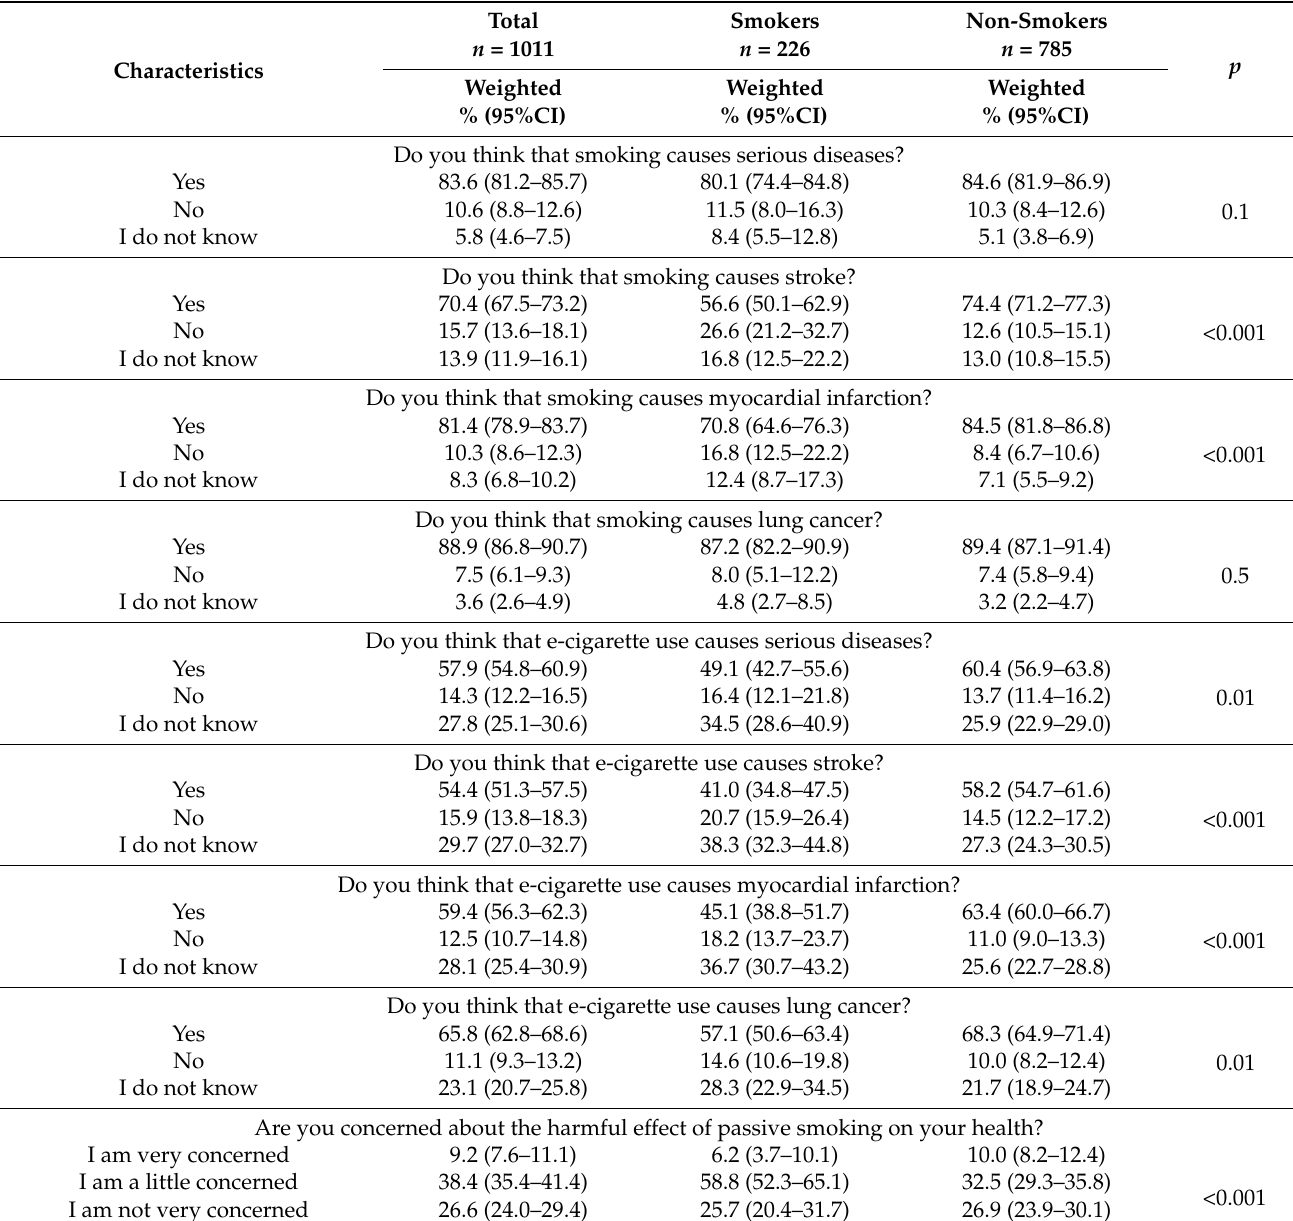
Table 1. Awareness of the health effects of using tobacco and e-cigarettes by smoking status ( n = 1011).